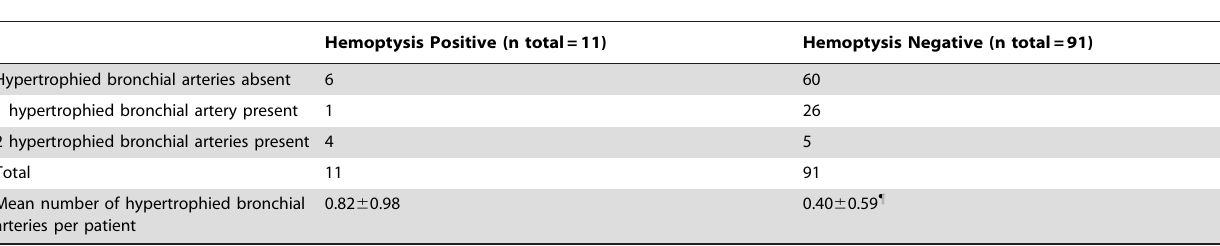
Table 2. Bronchial artery hypertrophy in hemoptysis positive and negative patients with available baseline CT angiography scans.